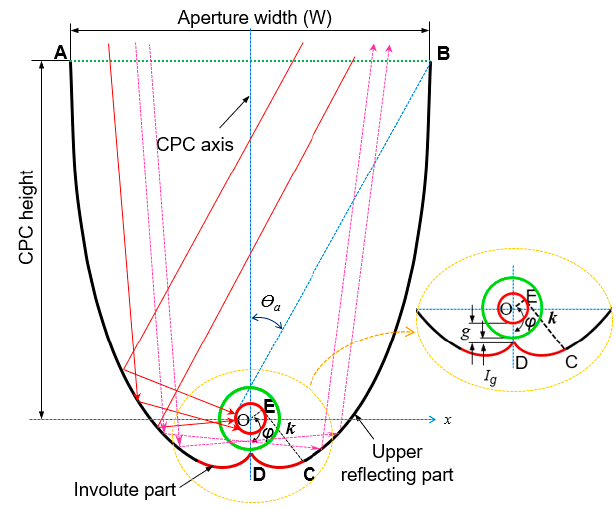
Figure 2. Cross-section of a two-dimensional compound parabolic concentrating (CPC) collector with evacuated tube receiver.